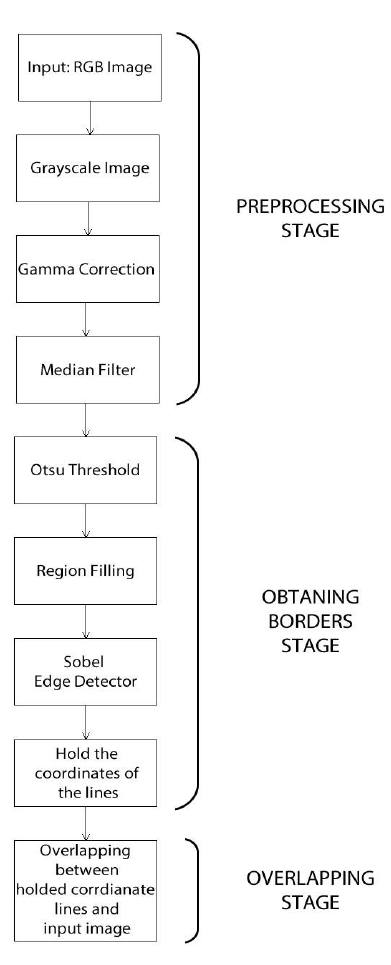
Figure 1. Flow chart of the proposed